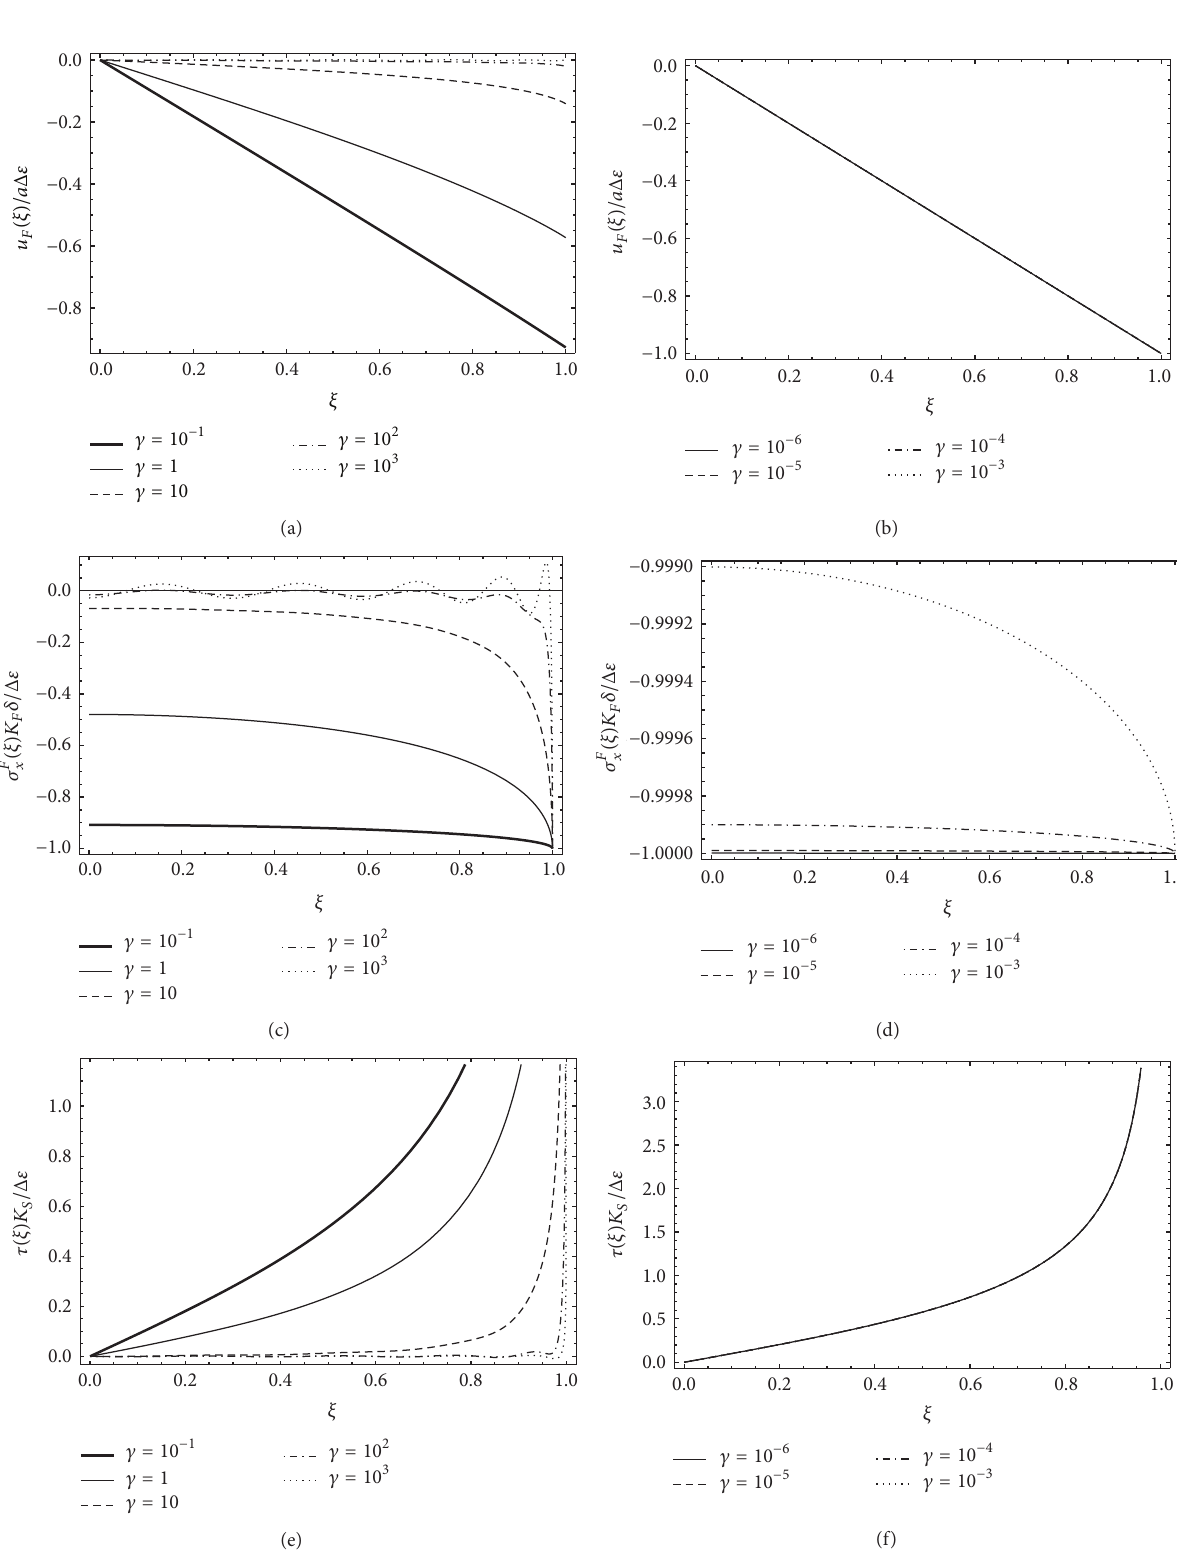
Figure 5: Longitudinal displacement, longitudinal stress, and shear stress field of symmetric loading case condition for high (left (a), (c), and (e)) and low (right (b), (d), and (f)) values of 𝛾 ,